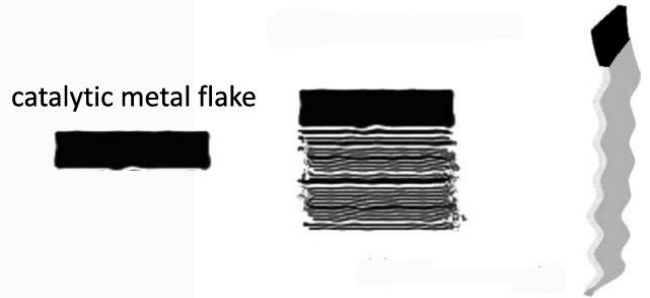
Figure 4. Schematic illustration of the typical chemical vapor deposition growth mechanism of the platelet CNFs [15].